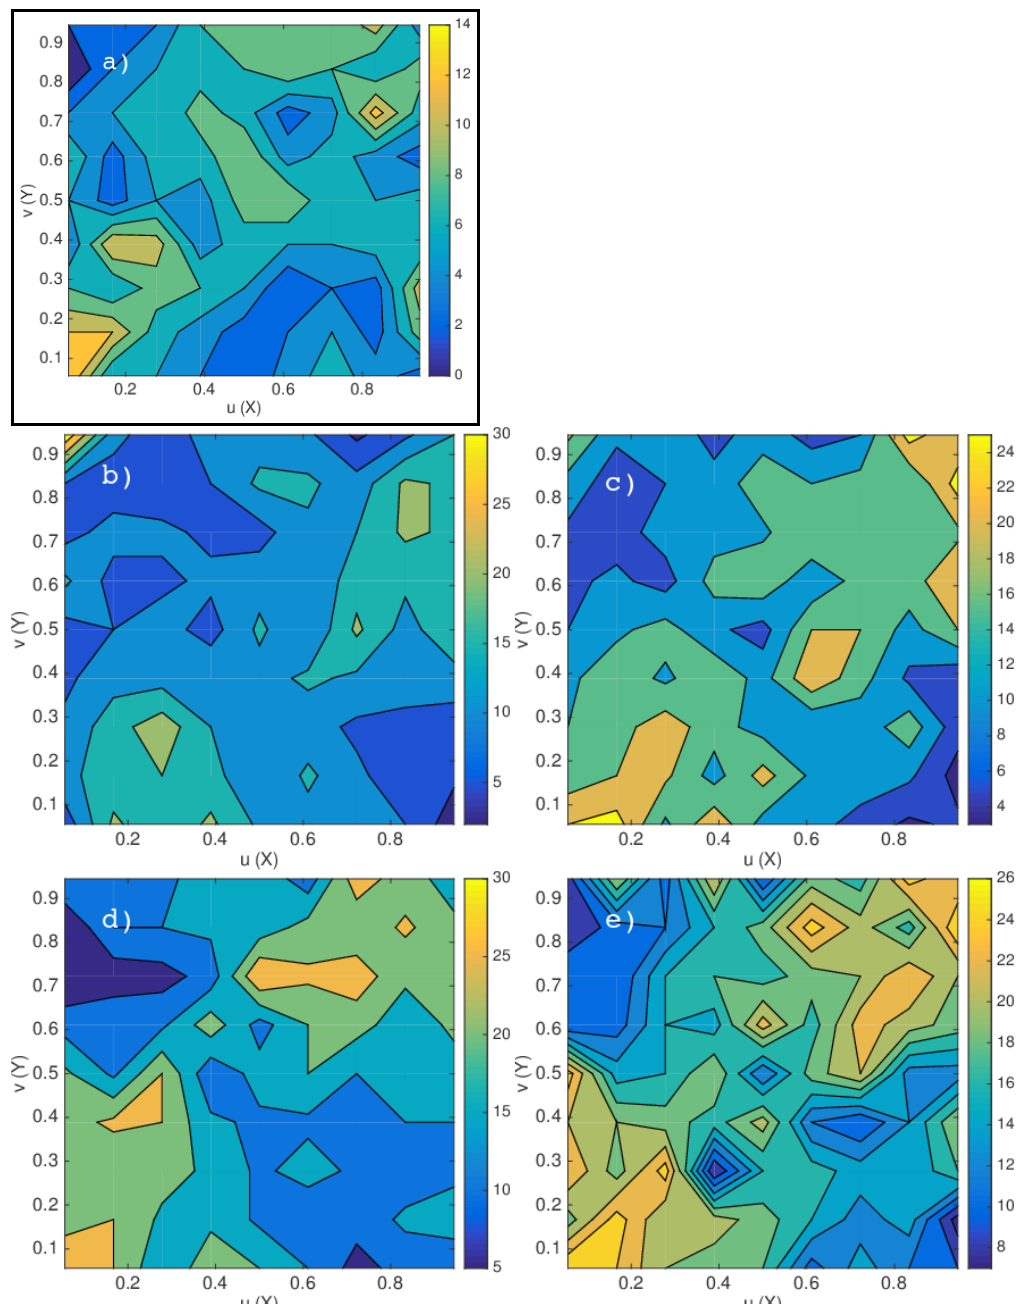
Figure 5. Same as Figure 4, but for station MERU. Figure 5. Empirical Copula (defined on 9 × 9 lattice) of the P&T pairs at MERU station ( X : precipitation, Y : temperature) from ( a ) observations, ( b ) WRF-BLA, ( c ) WRF-GWA, ( d ) WRF-KLA, and ( e )